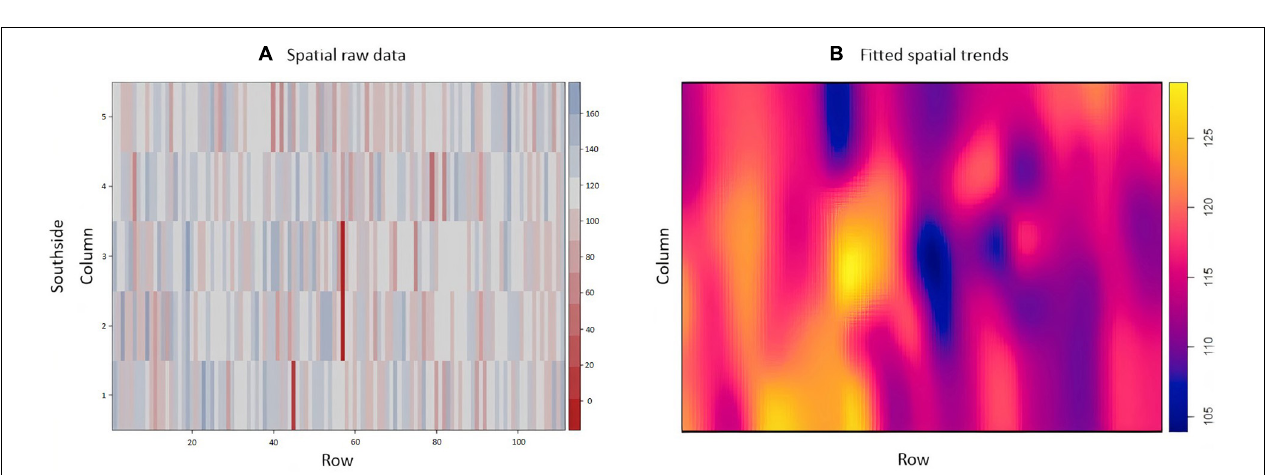
FIGURE 2 | Apparent electrical conductivity (ECa) map and overlap of the experimental plots on the ECa map with 11,722 reading points and the average values of the points of interest in the 0.375 m (A) and 0.75 m (B) layers, Experimental Area 1.